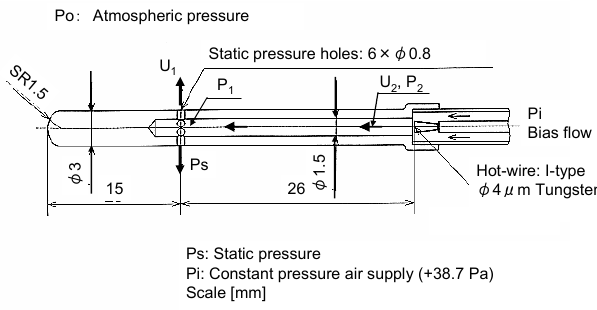
Fig. 3 Dimensions of the static pressure